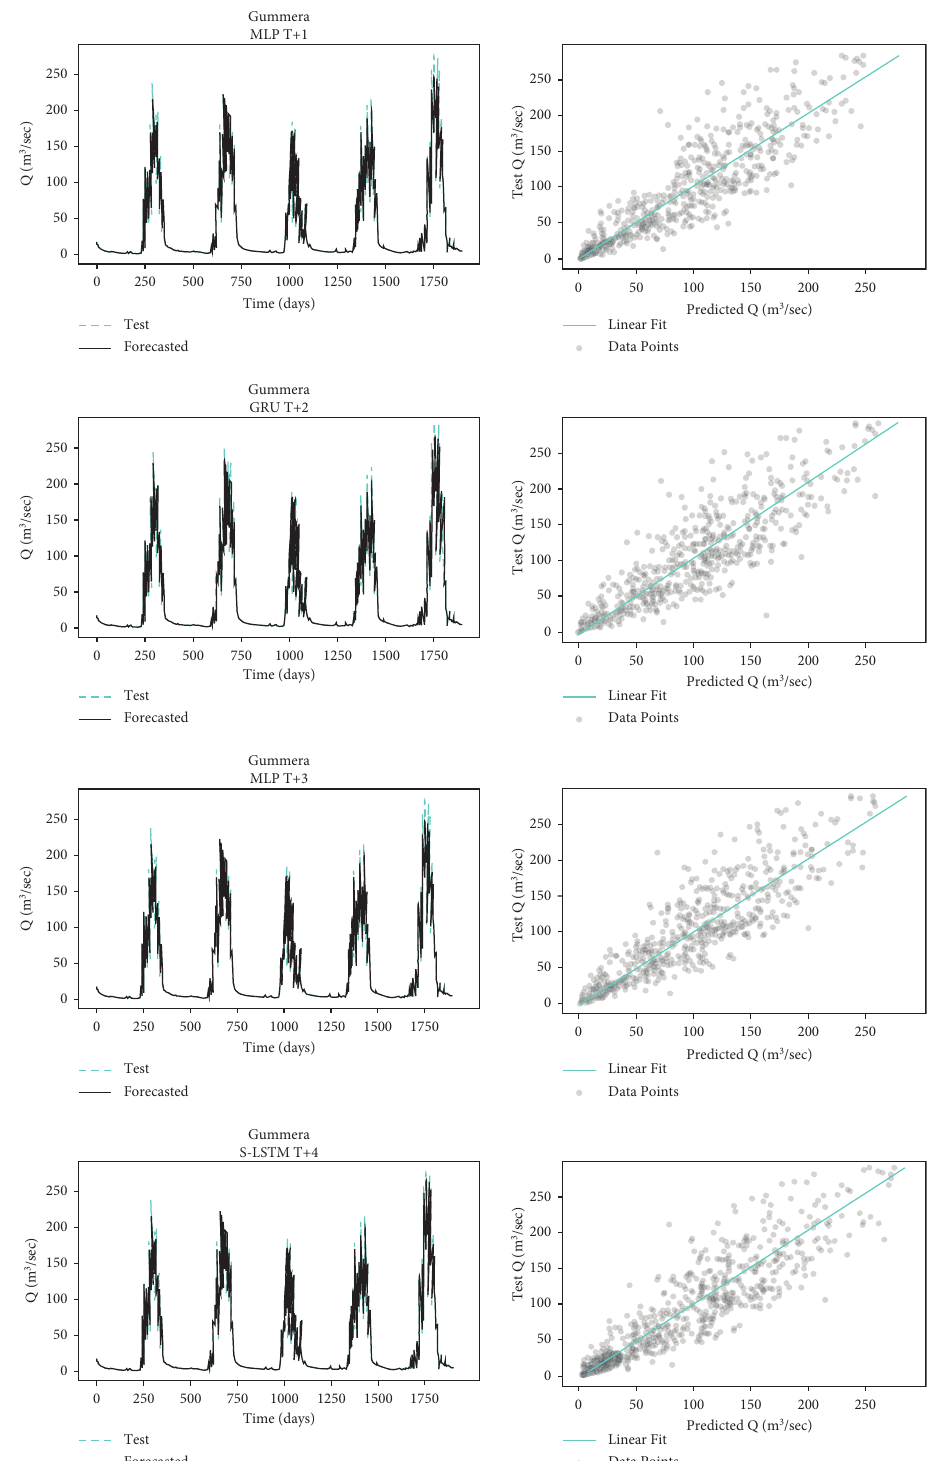
Figure 14: Comparison of true values and predicted values of the optimized high score deep learning model for each time lag (Gummera